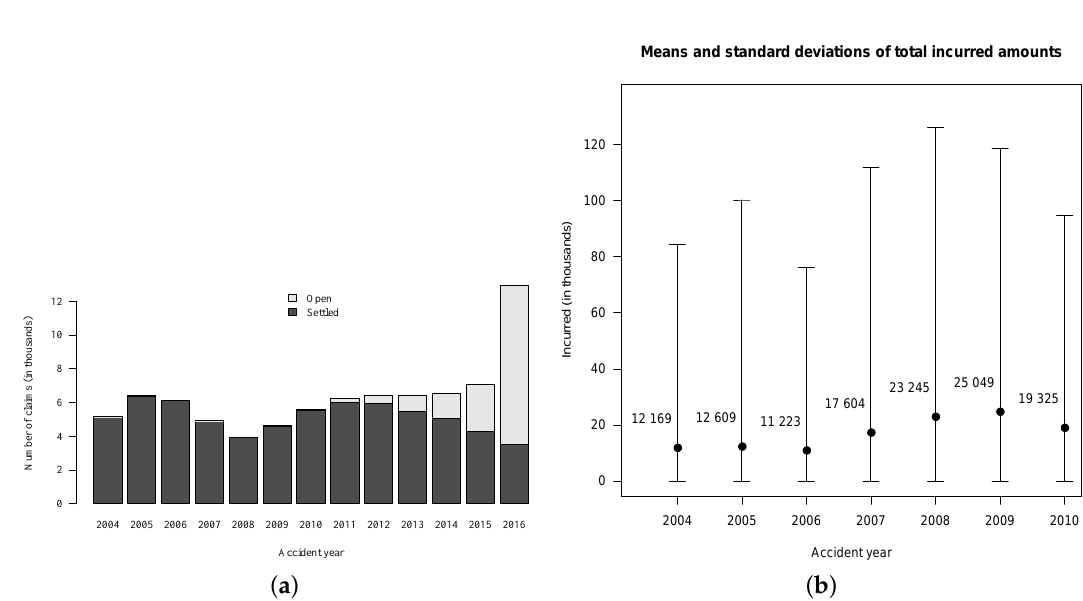
Figure 2. ( a ) Status of claims of incurred amounts on 31 December 2016; ( b ) Means and standard deviations of incurred amounts on 31 December